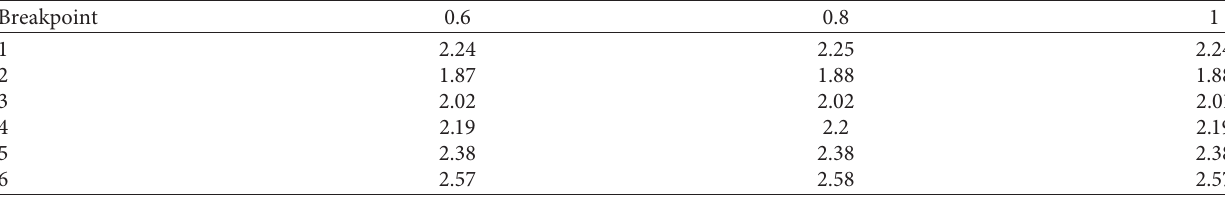
Table 12: The value of dev p for each breakpoint for the second sample problem.